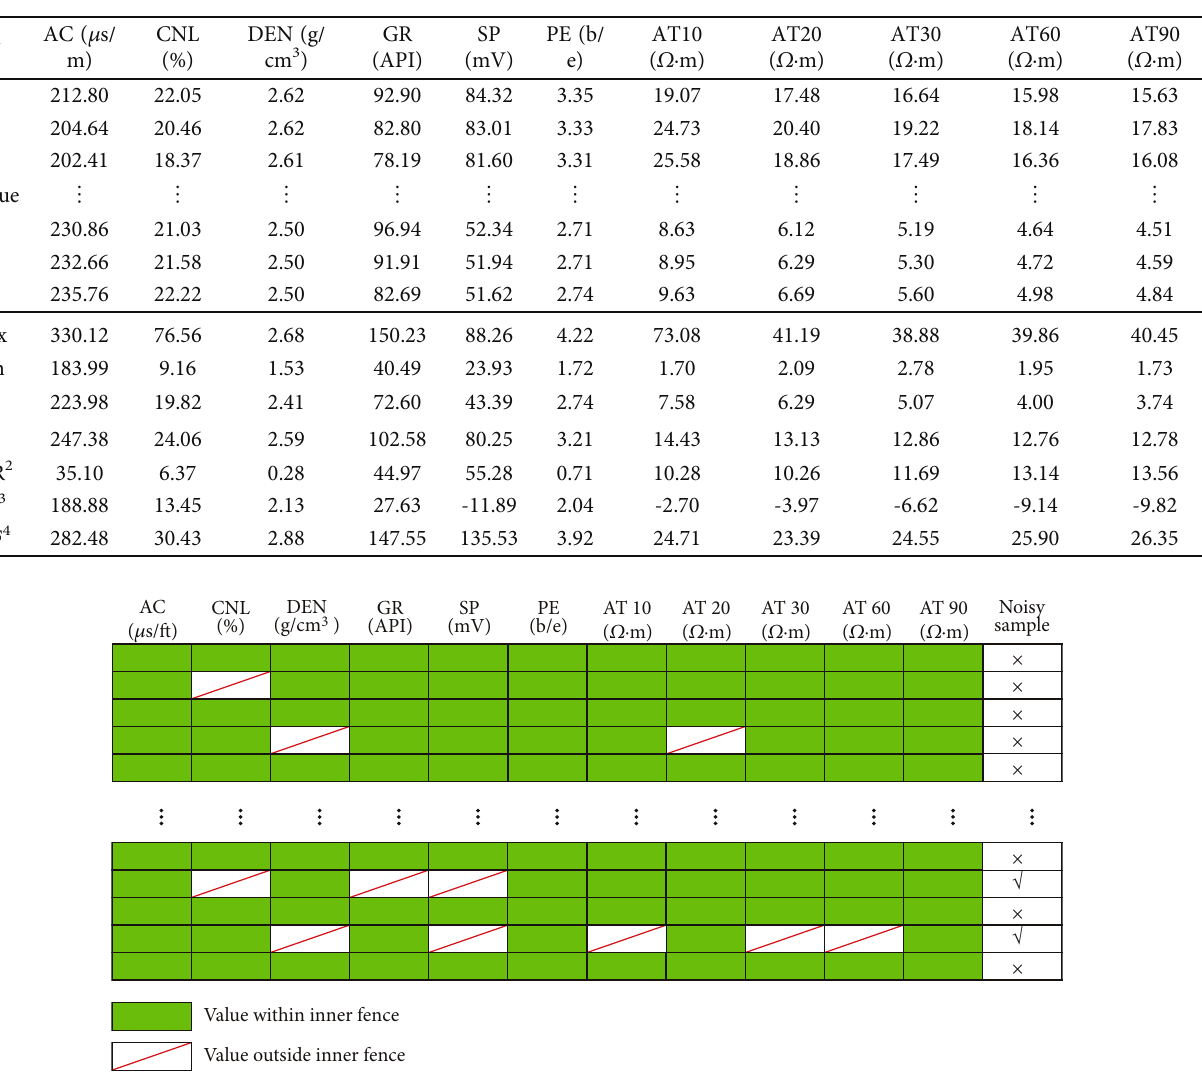
Figure 4: Judgment of noisy samples for logging samples. AC =acoustic log; CNL=compensated neutron log; DEN =density log; GR=gamma ray; SP =spontaneous potential; PE =photoelectric absorption cross-section index; AT10, AT20, AT30, AT60, and AT90=resistivity of formation measured by array induction log at 10-inch, 20-inch, 30-inch, 60-inch, and 90-inch logging